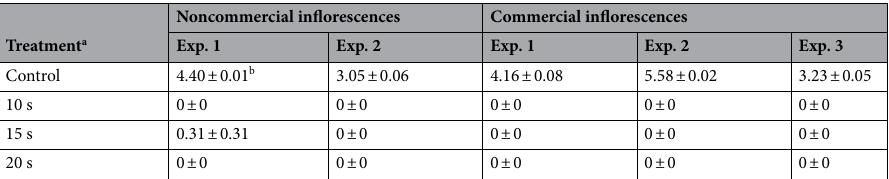
Table 1. Colony forming units ( CFU) levels in MC inflorescences. a CFU survival values for noncommercial and commercial inflorescences exposed to 10, 15 and 20 s steam treatments in the different experiments. b Values are presented as log 10 (CFU/g inflorescence) ± standard